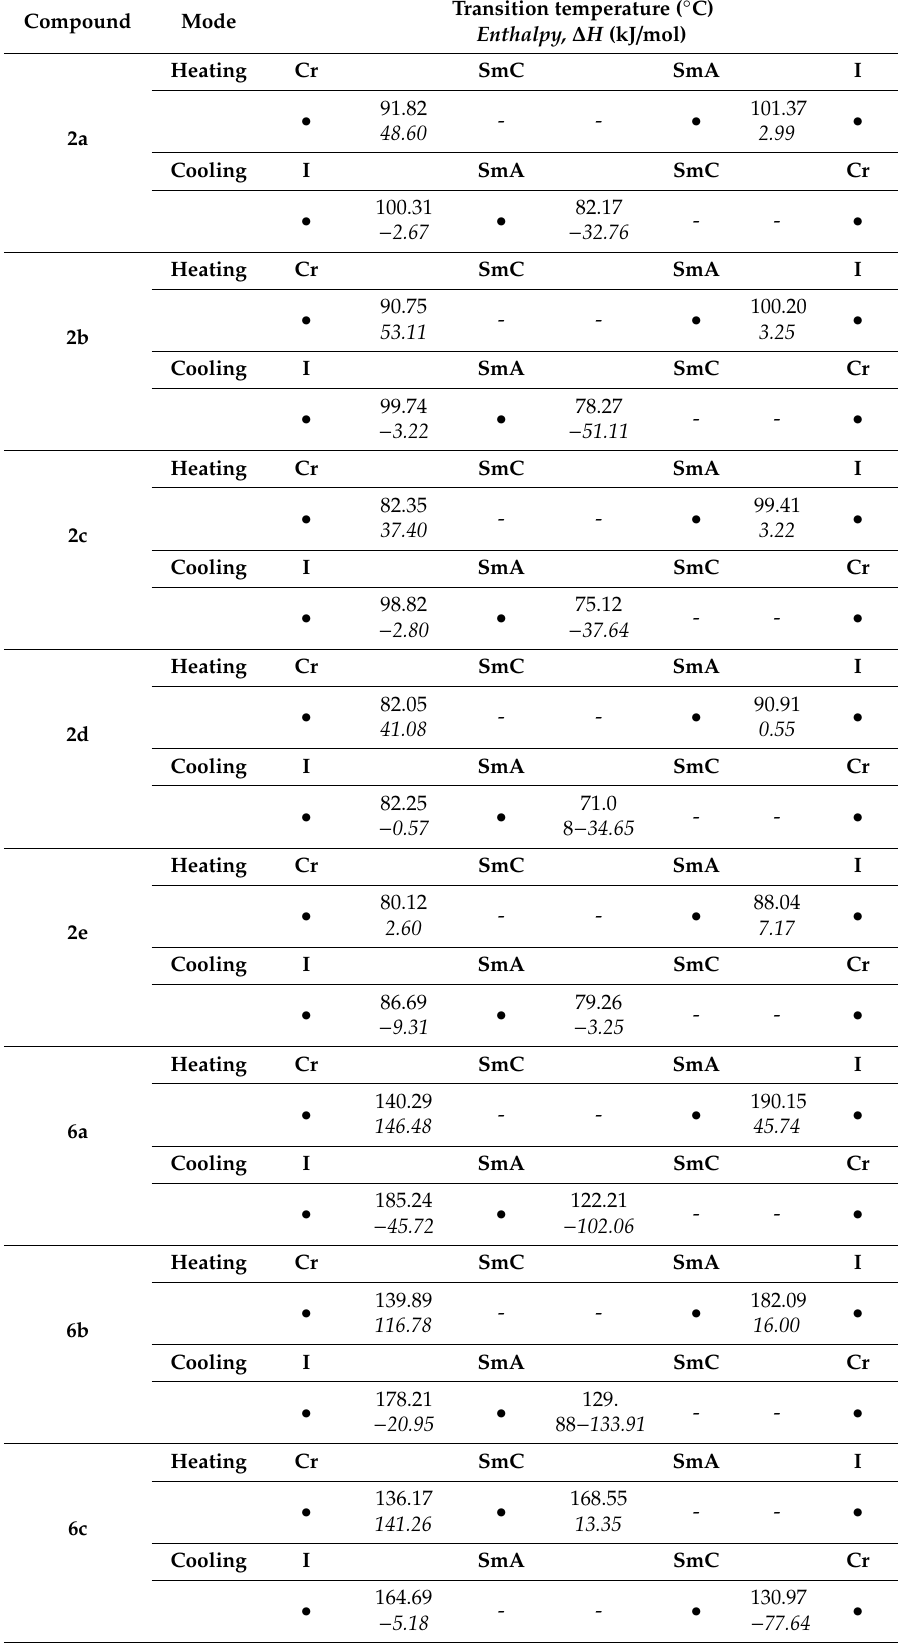
Table 2. Phase transitional properties of 2a–e, 6a–e , and 8a–e upon heating and cooling cycles.